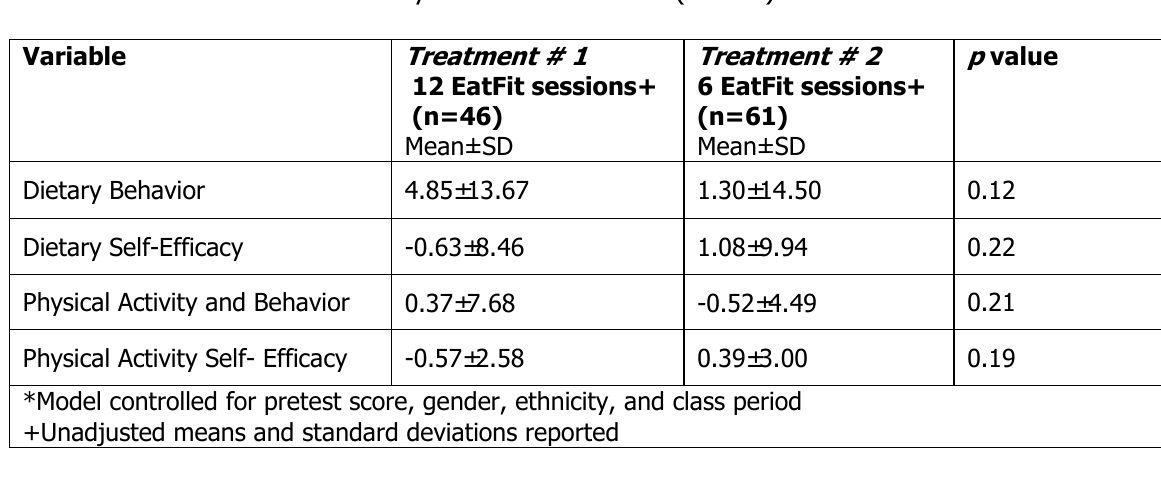
Change Scores for Treatment #1 and Treatment #2 Participants by Outcome Variable*